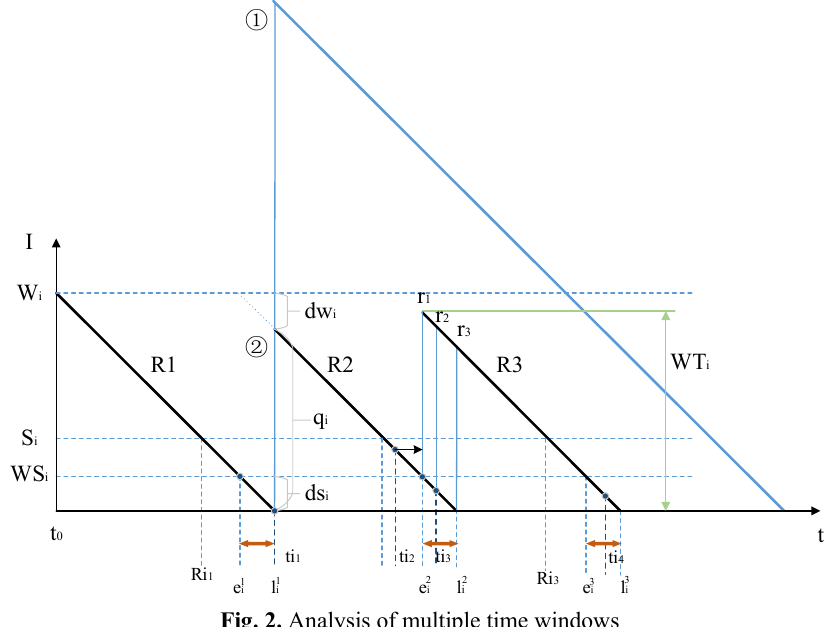
Fig. 2. Analysis of multiple time